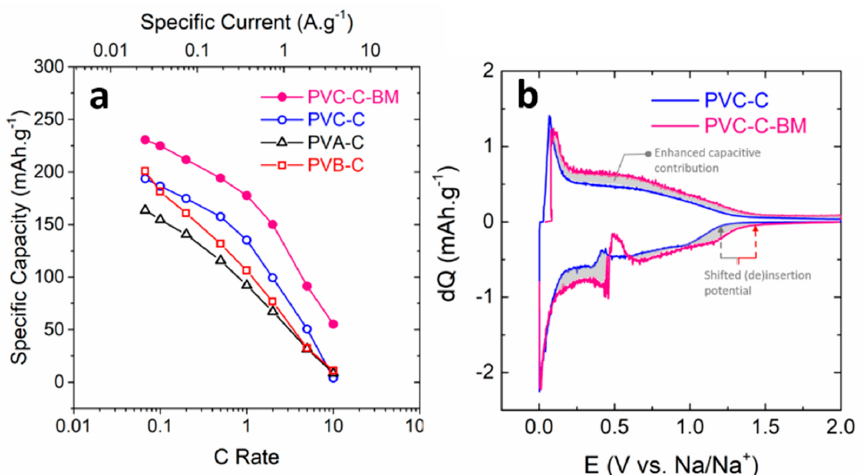
Figure 4. ( a ) Rate capability (based on Q rev in the fifth cycle of each load) of the polyvinyl-derived soft carbons at various current loads ranging from C / 15 to 10C; and ( b ) derivative curve, dQ vs. potential, of the PVC-derived soft carbons (BM stands for ball-milled) at C / 15, (C = 372 mA · g − 1 ). It is already known that increasing the specific surface area of the carbon materials (e.g., by